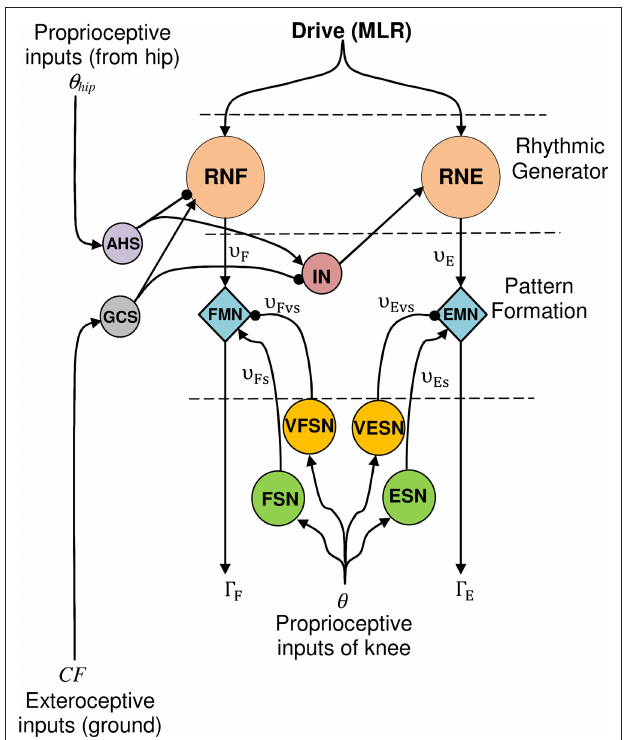
Figure 9 | CPg model for the knee articulation (for more clarity, the hip level is not depicted). Proprioceptive inputs come from the hip ( θ extension) and exteroceptive from the ground (CF: intensity of vertical    component CF of the contact force F